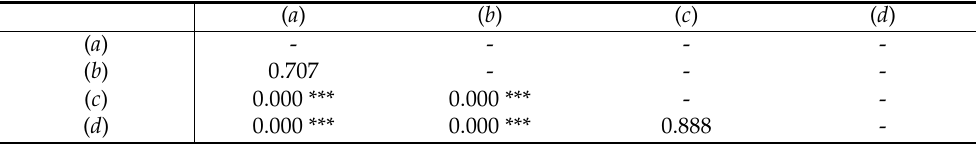
Table 3. Kruskal–Wallis test of lateral FDE of different combinations of features.